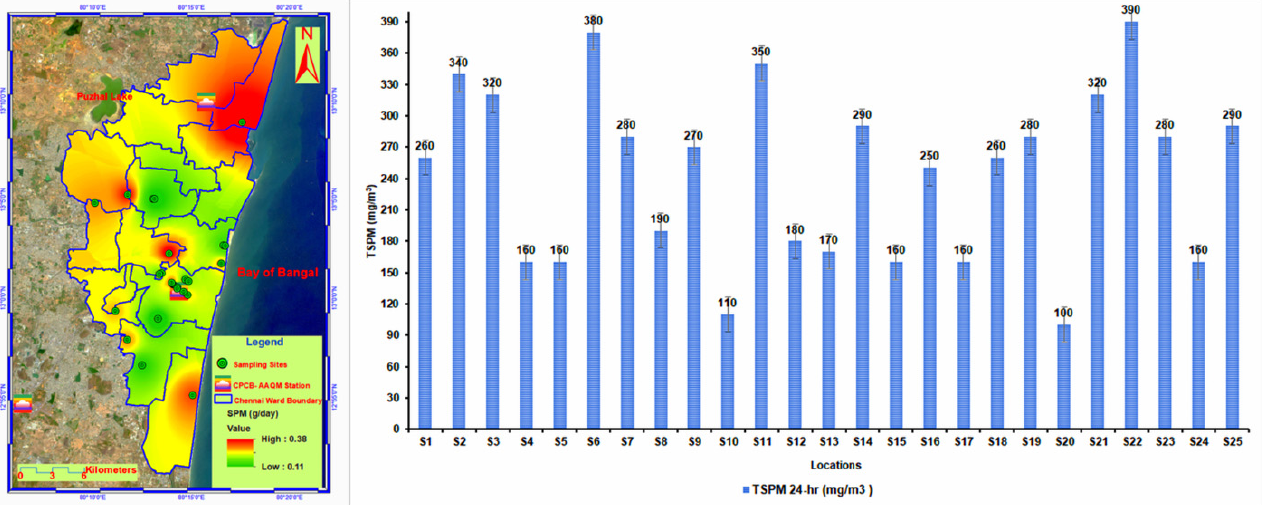
Figure 3. The spatial variation of indoor environmental suspended particulate matter (SPM) (g/day) and station-wise concentration (mg/m 3 ) of SPM in the study area.